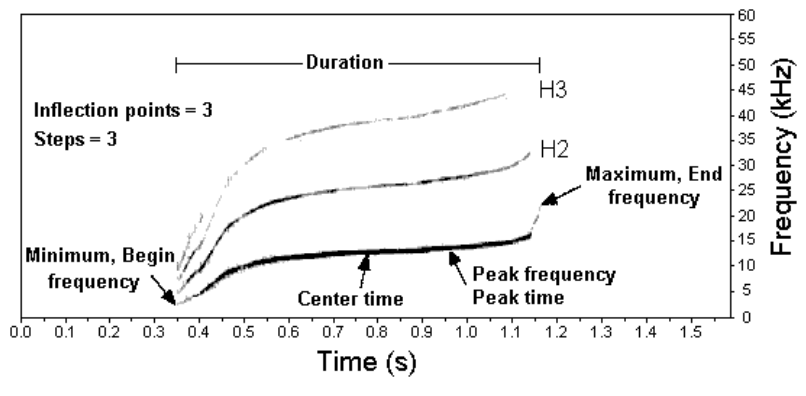
Fig. 1 – Spinner Dolphin whistle showing the fundamental frequency or whistle contour and two harmonics (H2 and H3). The 10 whistle parameters extracted are also